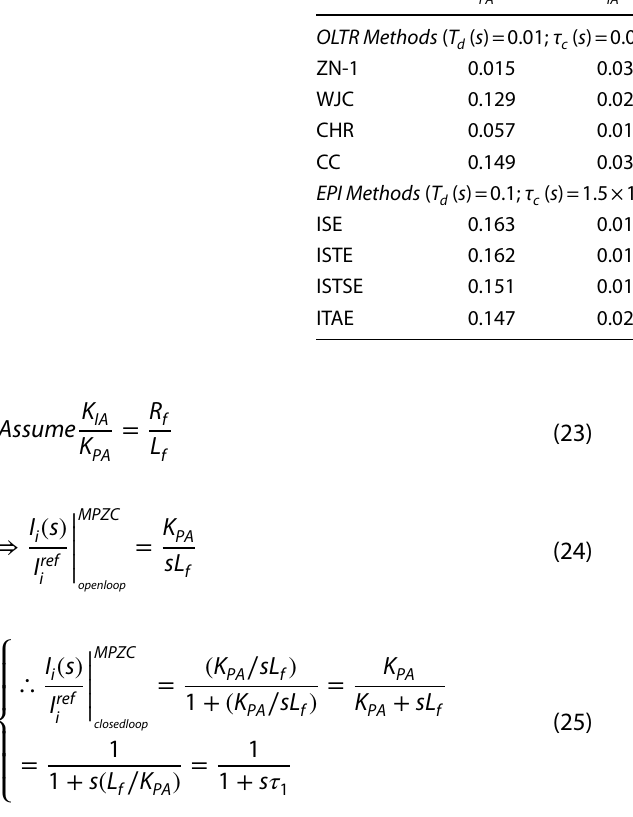
Table 7 V/I Controller gains tuned by OLTR/EPI methods